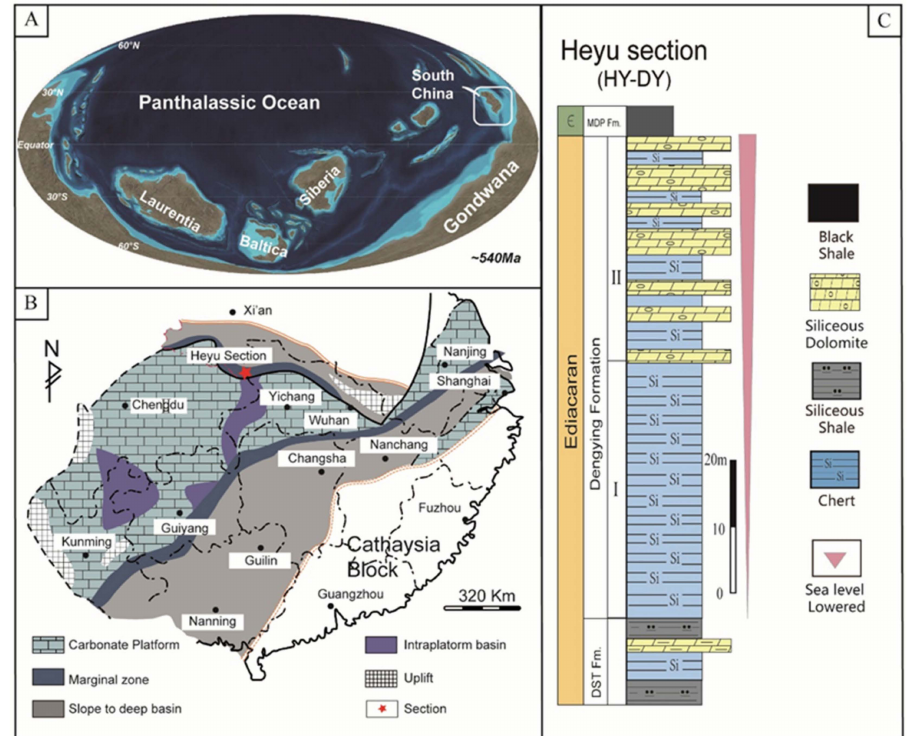
Figure 1. Palaeogeographic map and stratigraphic column. ( A ) Global paleogeography at ~540 Ma. ( B ) Paleogeographic map of the Yangtze Block during the Ediacaran–Cambrian transition (modified from [52]). ( C ) Lithological column of the Heyu section (modified from [48]).